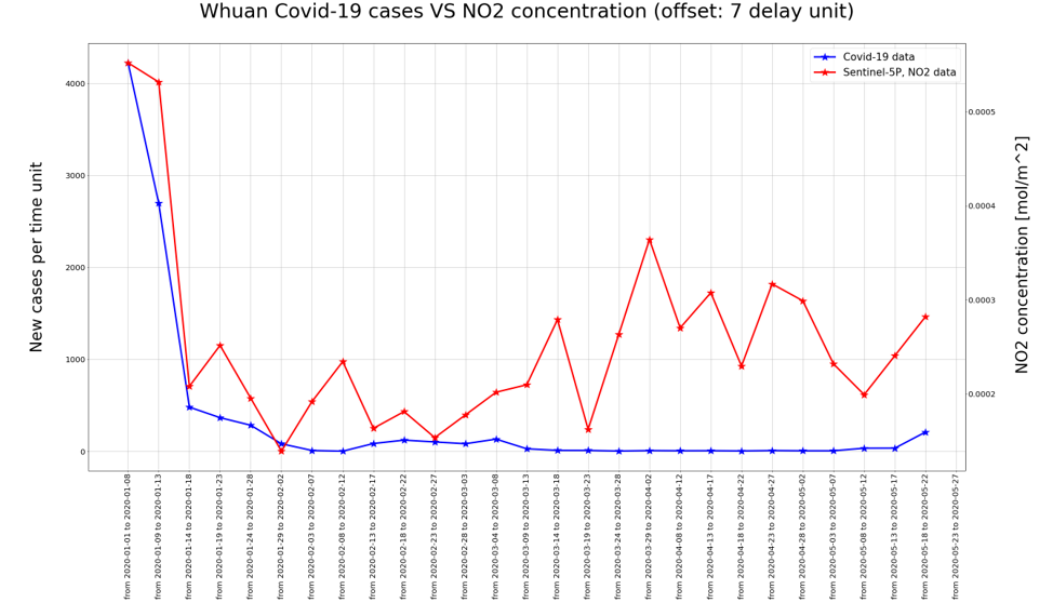
Figure 18. New daily cases vs. average concentration of NO 2 in